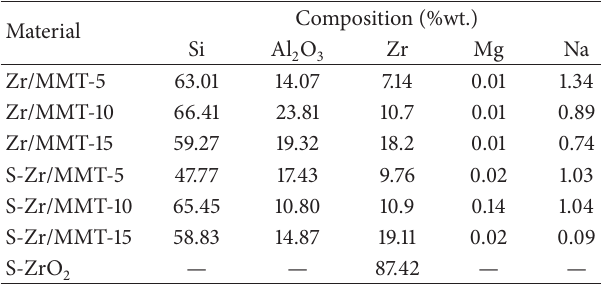
Table 1: Result of elemental analysis of materials.